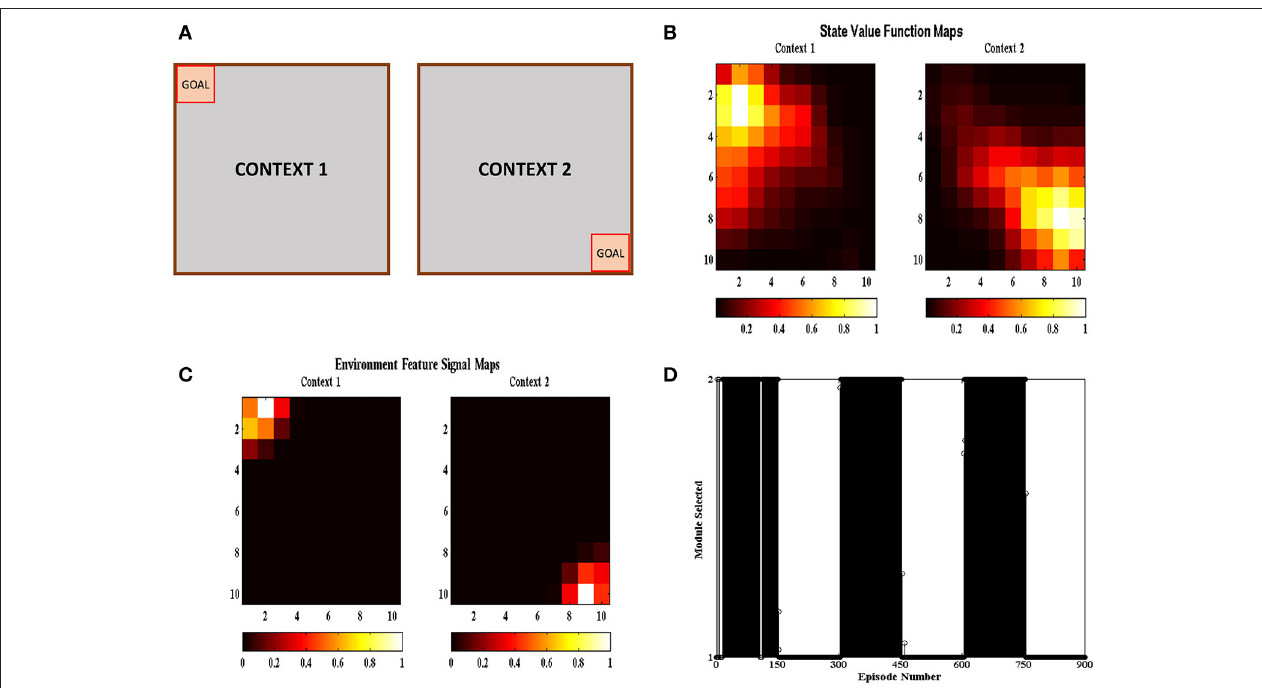
FIGURE 6 | (A) Schematic of the gridworld used in the task. A goal is switched between the top left and bottom right corner every 150 episodes. (B) State value map estimated by the agent at different spatial locations across different contexts. We can see that the state value peaks at the goal location corresponding to the context. (C) Environment Feature Signal maps estimated by the agent at different spatial locations across different contexts. We can see that the state value peaks at the goal location corresponding to the context. (D) Modules chosen by the agent at different episodes. We can see that the module chosen switched with change in context indicating that the agent is able to identify the context it is currently present